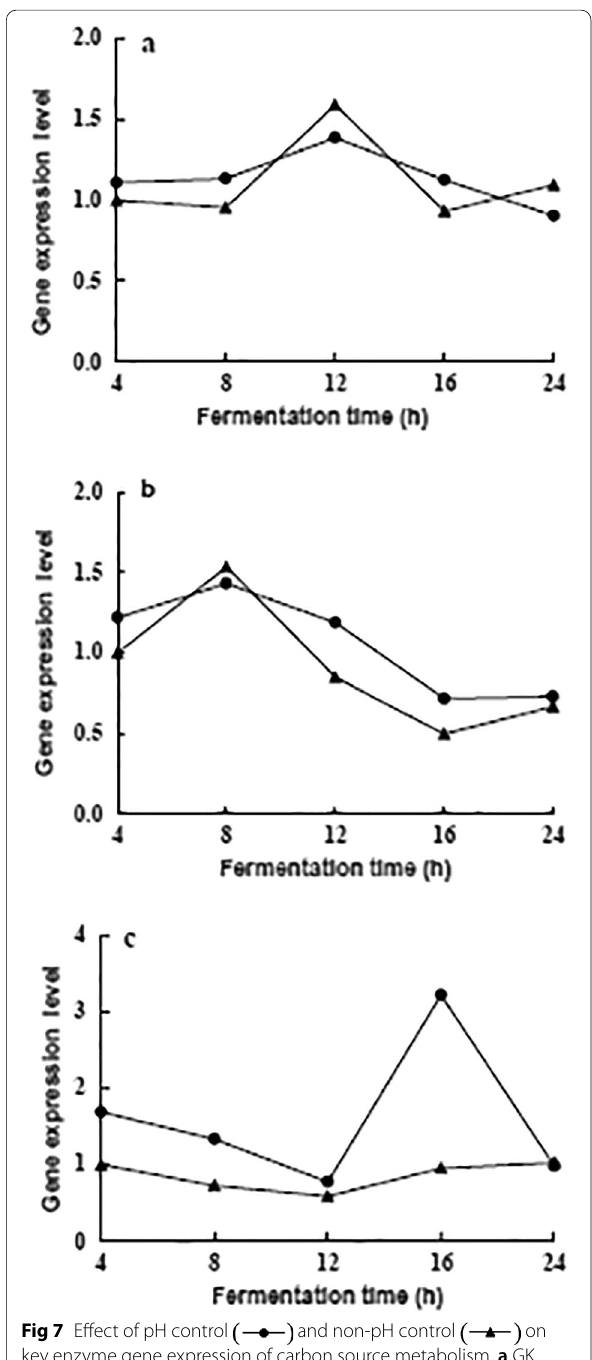
Fig 7 Effect of pH control and non-pH control on key enzyme gene expression of carbon source metabolism. a GK, glucokinase; b INV, invertase; c PFK,